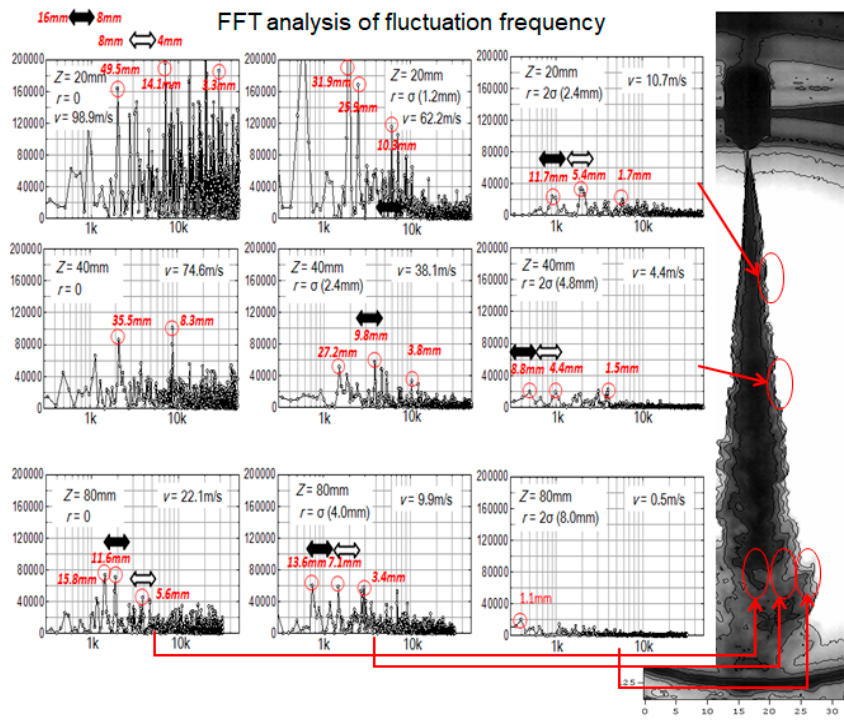
Figure 4. Frequency analysis of diesel spray fluctuation. It was obtained by FFT analysis on spray velocity measured by PIV ( D n = 0.17 mm, P inj = 90 MPa, P a = 1 MPa). Red values represent the wavelength corresponding with the frequency.